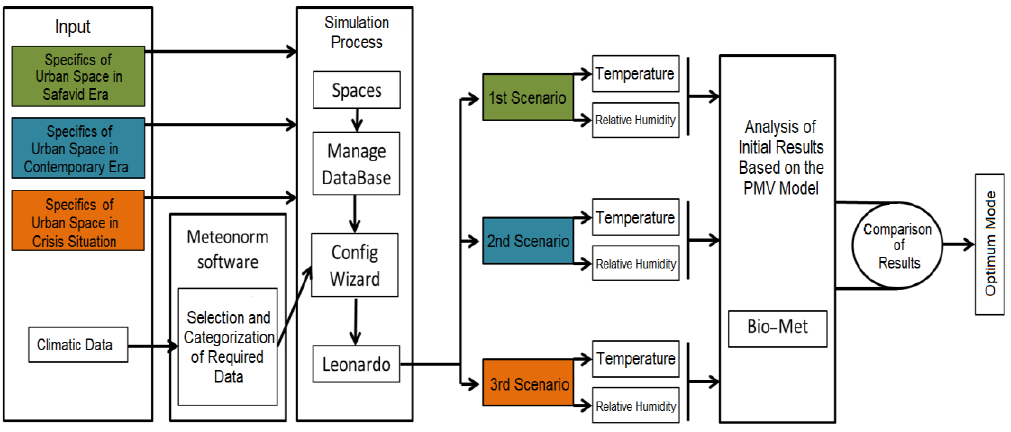
Figure 4. The methodological process of the study.